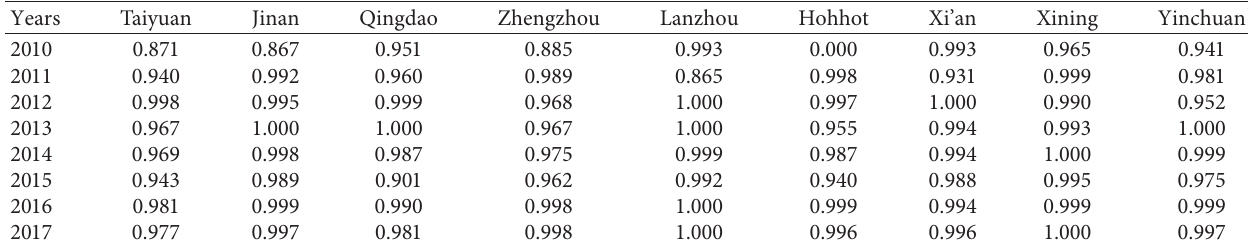
Table 4: Coupling degree of social economy and resources